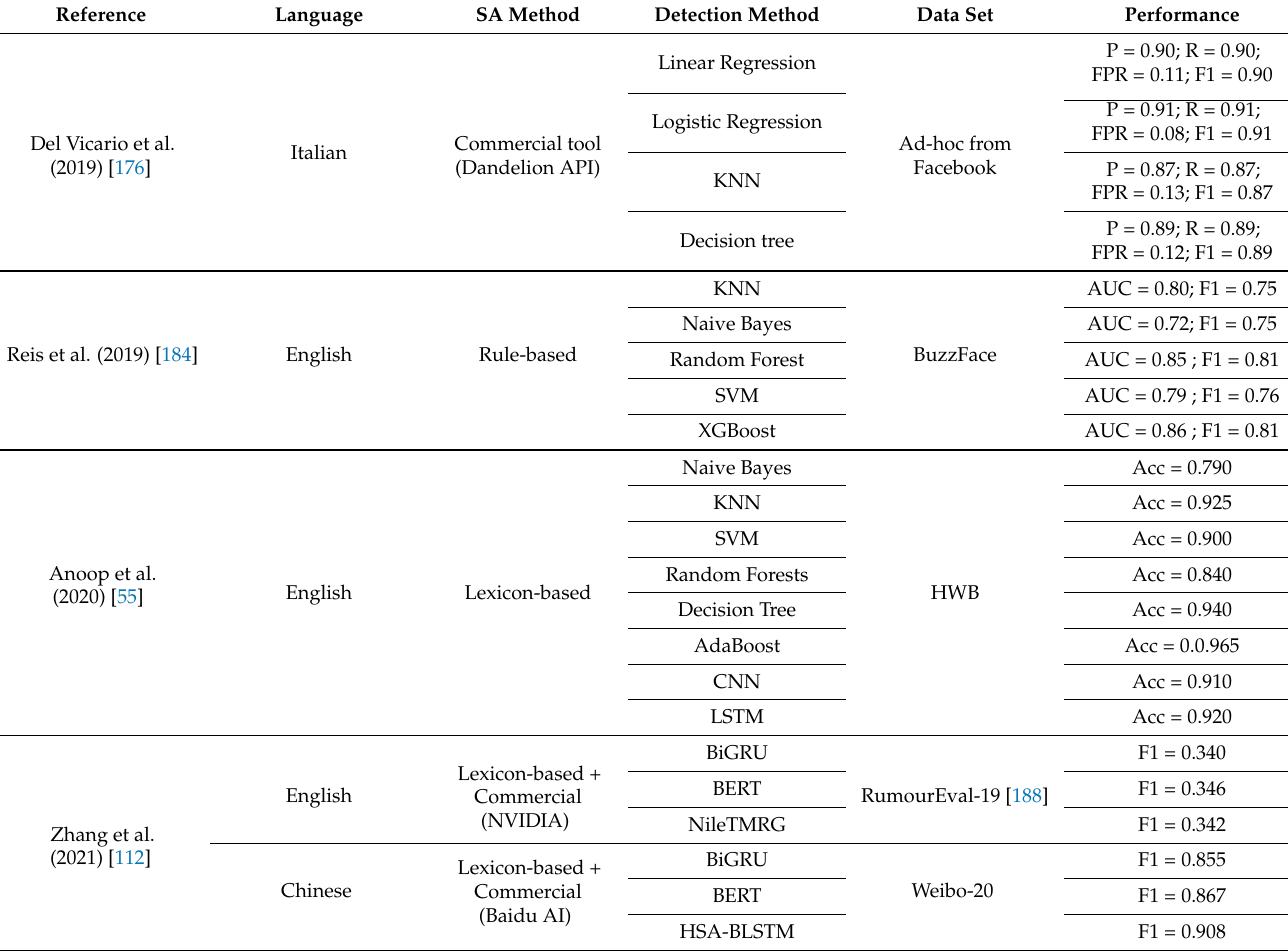
Table 3. Main characteristics of fake news detection systems using SA: systems that provide quantitative performance results on the task (part 2 of